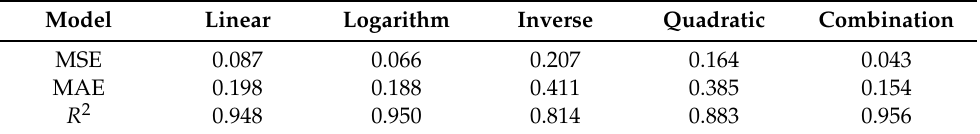
Table 8. Functional form. MSE, mean square error; MAE, mean absolute error; R 2 , coefficient of